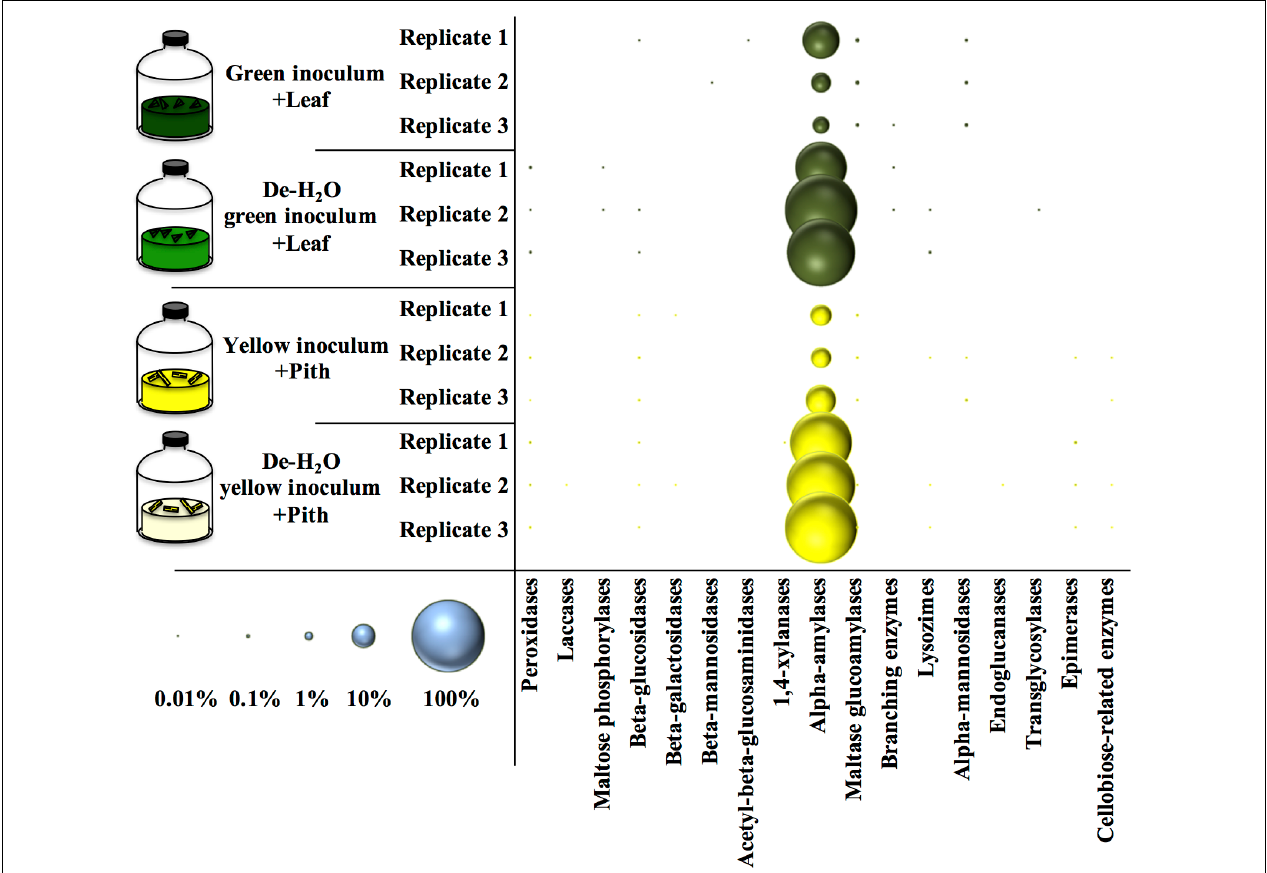
Table S7 . Blue circles (bottom left) indicate the scale of relative abundance of all metaproteins (from 0.01 to 100%). Keys reported in the